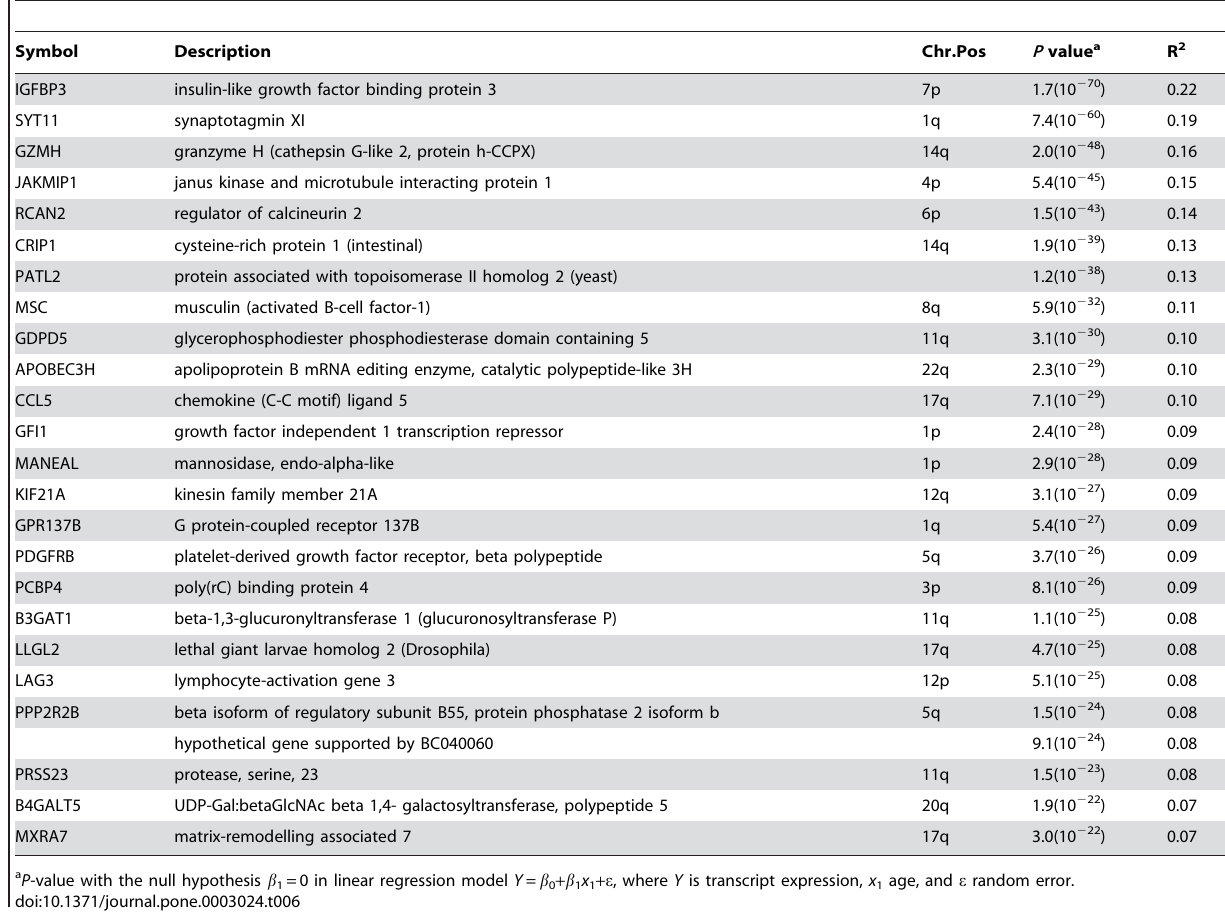
Table 6. Genes whose expression increases with age in human lymphocytes.